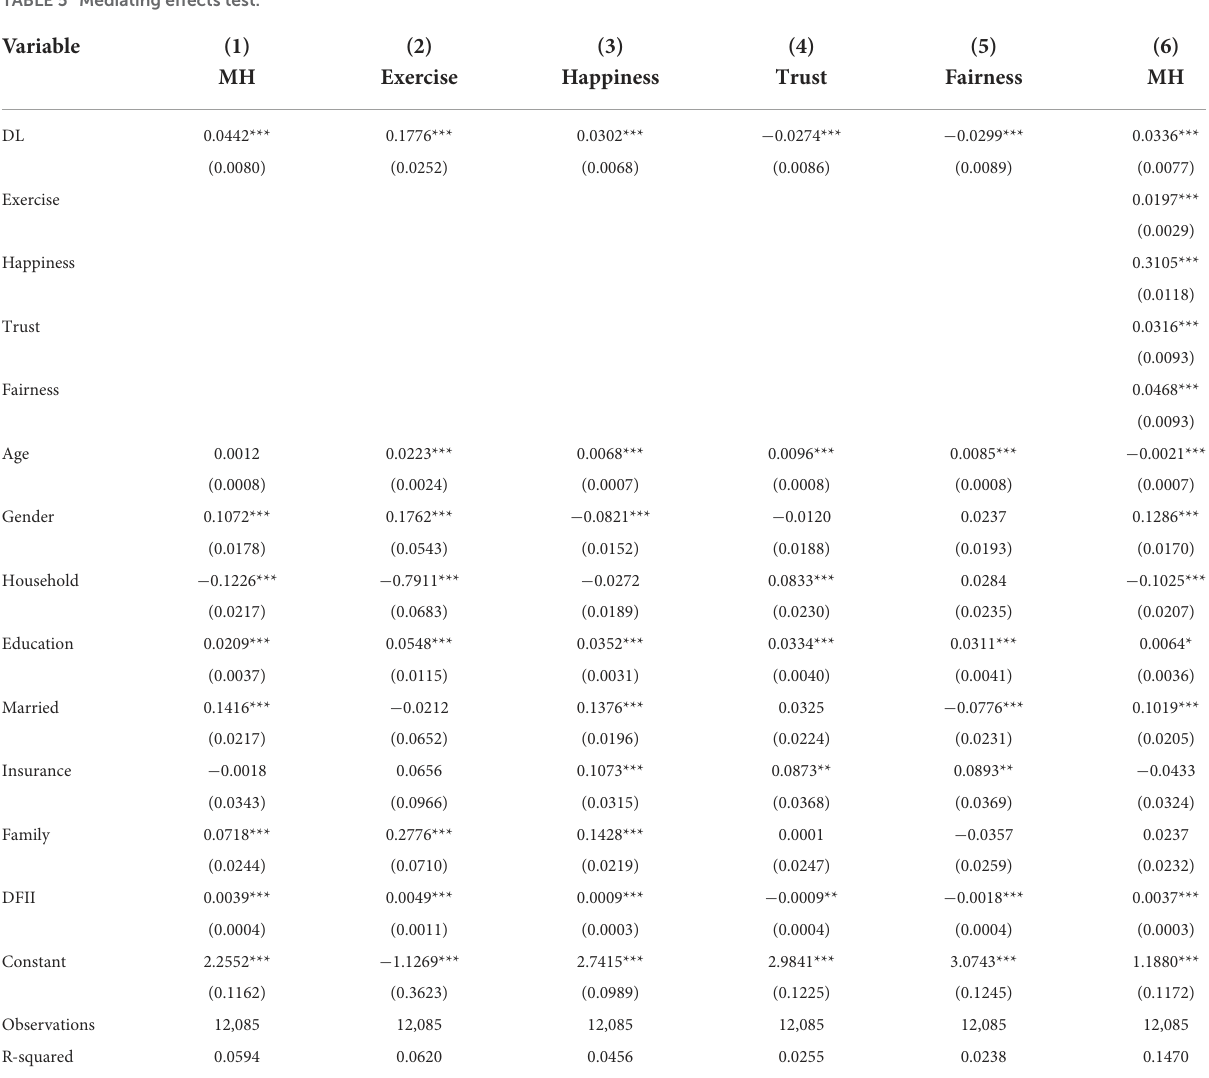
TABLE 5 Mediating effects